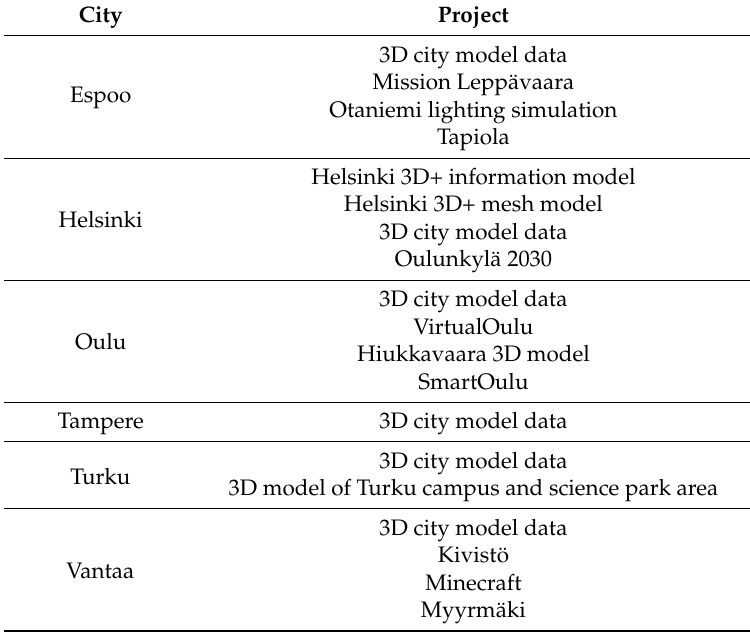
Table 1. A list of selected 3D city modeling activities within six largest cities in